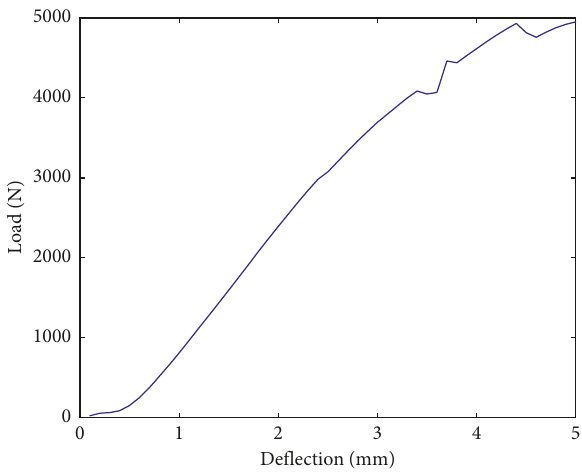
Figure 5: Bending load-deflection curve.